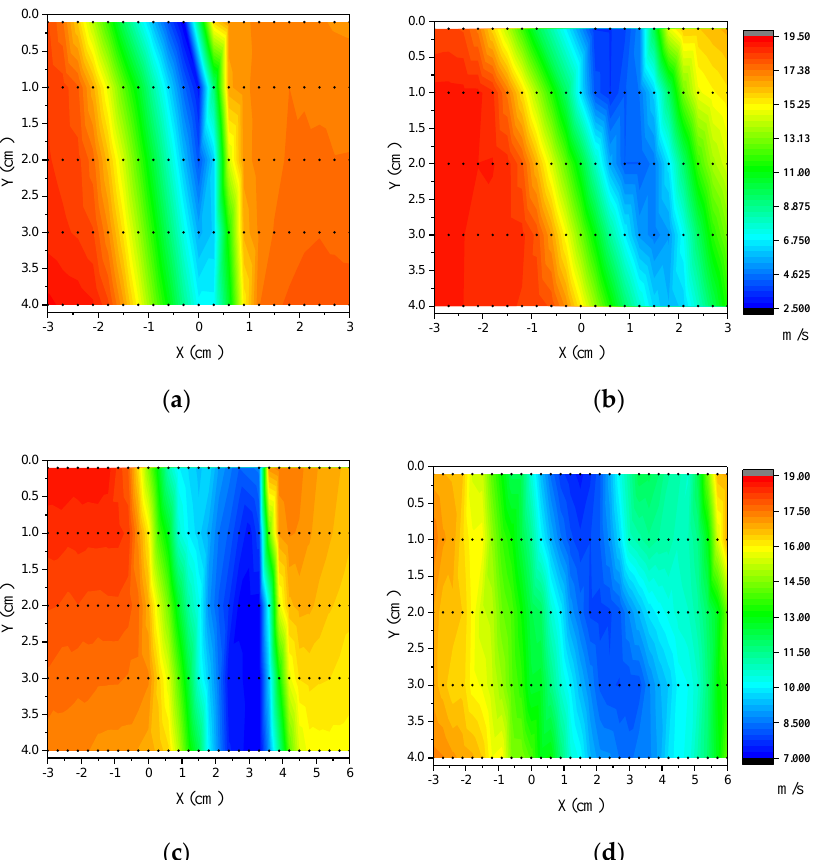
Figure 18. Velocity distribution of the region behind trailing edge (uniform inflow, Re: 0.8 × 10 6 ). ( a ) α = 8.4°, baseline airfoil; ( b ) α = 8.4°, Gurney flap 9 mm × 4.5 mm; ( c ) α = 11.4°, baseline airfoil; ( d ) α = 11.4°, Gurney flap 9 mm × 4.5 mm.